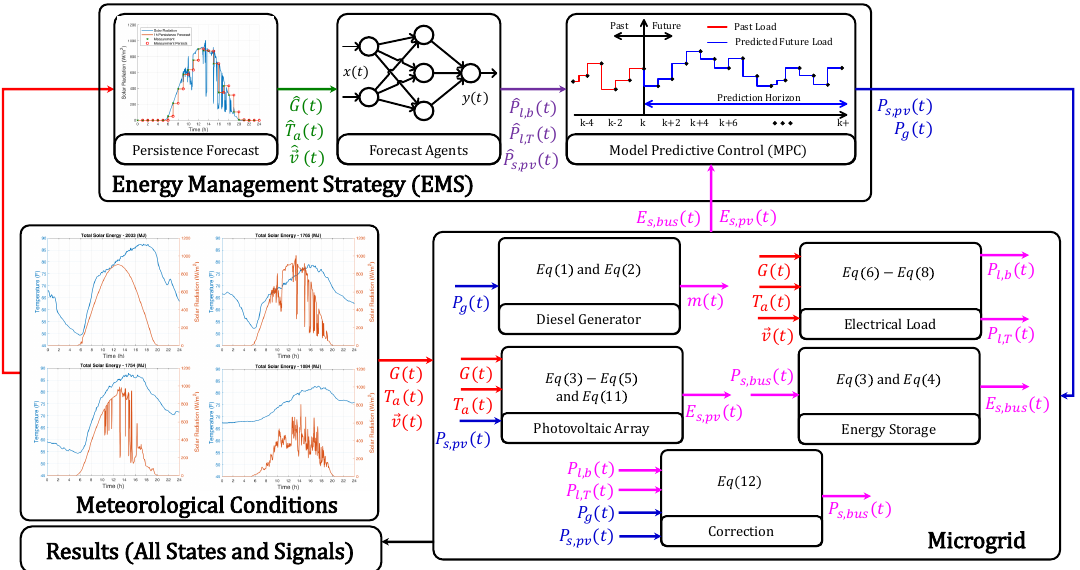
Figure 4. PWFs were constructed from the variable meteorological conditions, and passed to the forecast agents which predict the aggregate electrical load and power generated by the PV’s. The power forecasts and microgrid measurements were then used to inform the MPC’s optimization routines. The output of the MPC was then used to control the microgrid, subject to the meteorological